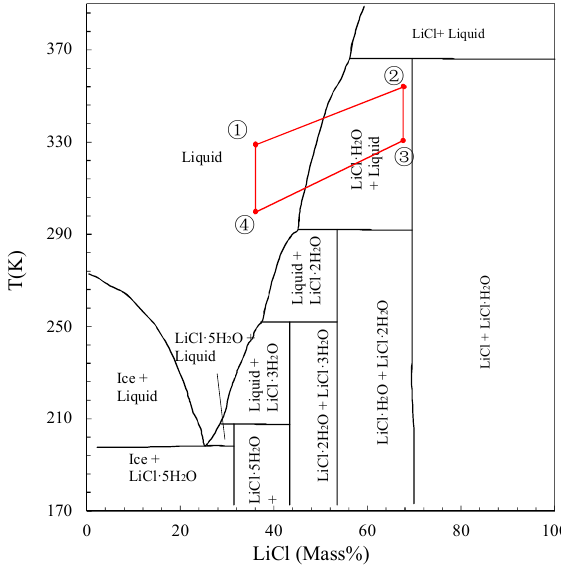
Figure 5. Phase diagram for the LiCl + H 2 O system [37].